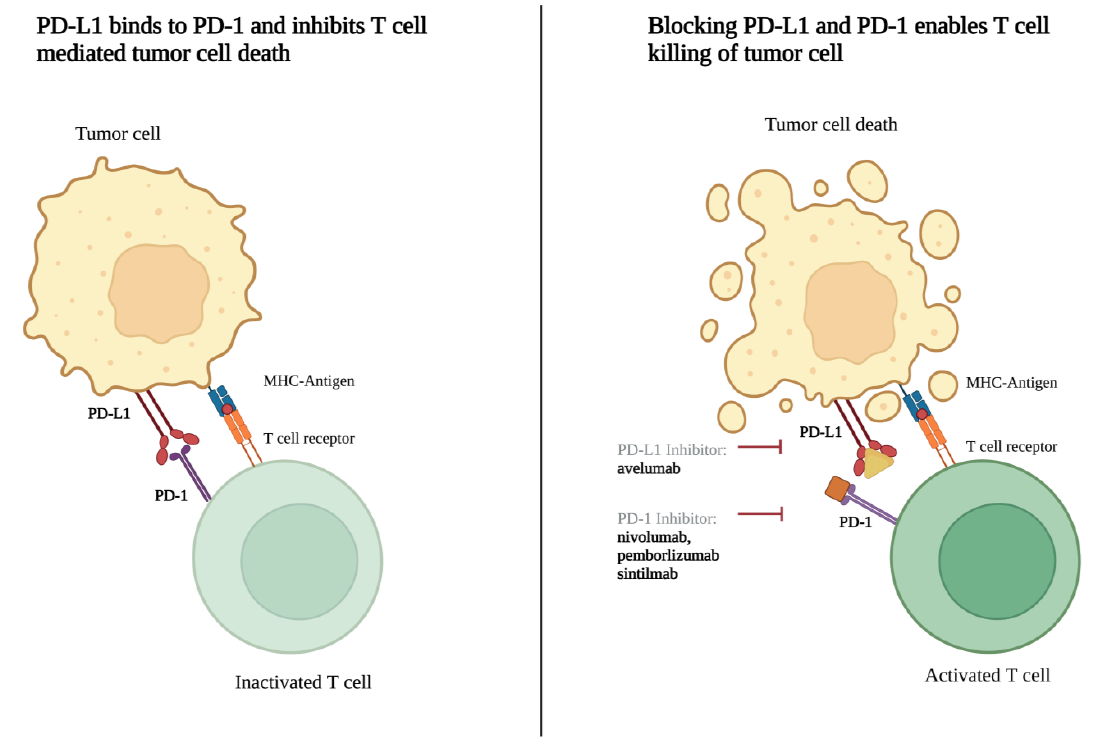
Figure 3. Mechanism of PD-1 to PD-L1 interaction inhibition. Made on biorender.com.